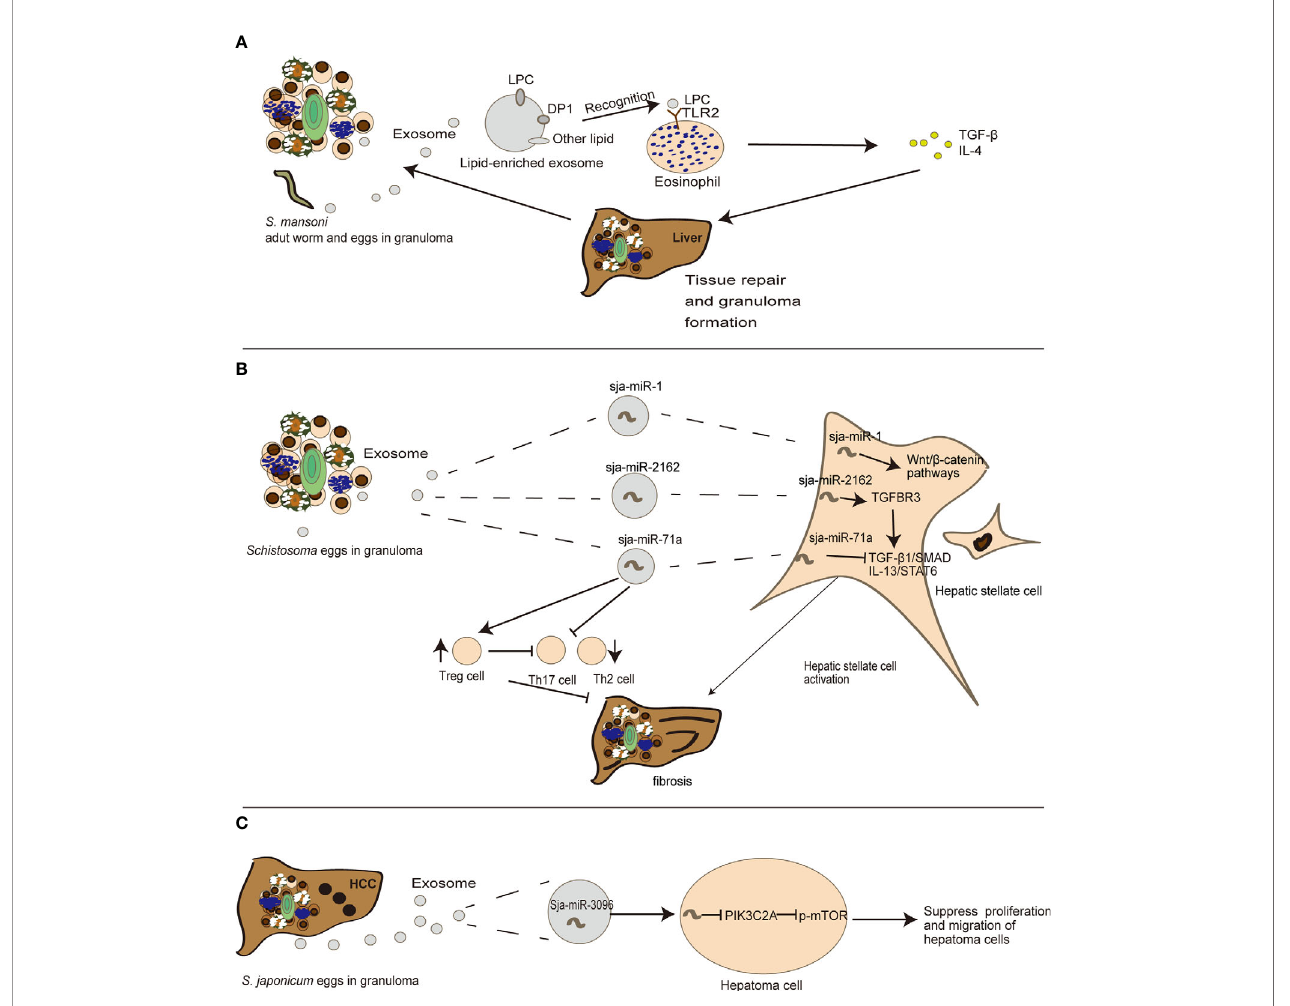
FIGURE 2 | The detailed mechanism of the role exosomes play in the evolution of egg-induced granuloma to liver fi brosis. (A) S. mansoni egg-derived exosomes can promote eosinophil activation, transferring LPC (lysophosphatidylcholine) to recognize TLRs (Toll-like receptors) on eosinophils, thus participating in tissue repair. (B) S. japonica egg-derived exosomes can carry sja-miR-71a, sja-miR-1 and sja-miR-2162 to modulate HSC activation, thereby participating in the process of liver fi brosis. (C) sja-miR-3096 in S. japonicum egg-derived exosomes can suppress hepatoma proliferation and